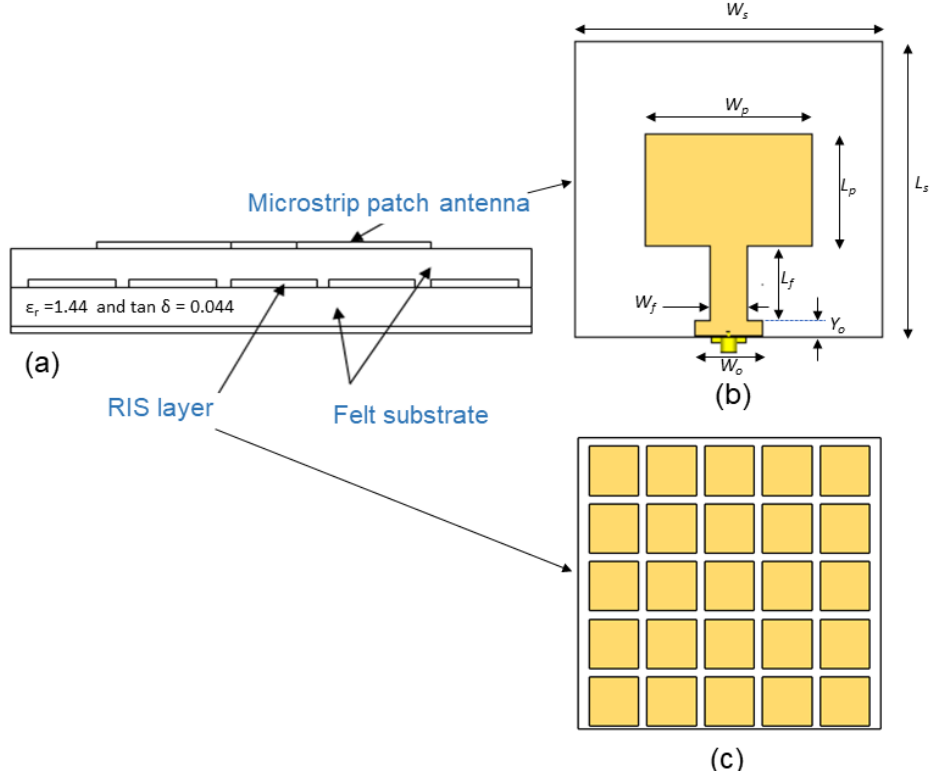
Figure 2. Schematic diagram of the proposed antenna and the RIS array: ( a ) side view of patch antenna with RIS, ( b ) First layer: front view of patch antenna and ( c ) Second layer: 5 × 5 array of RIS.